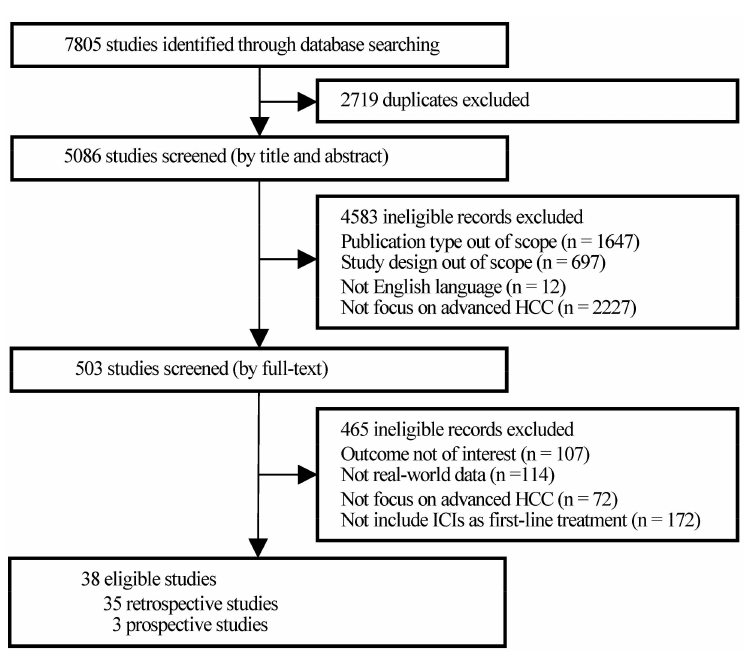
Figure 1. PRISMA flowchart of study